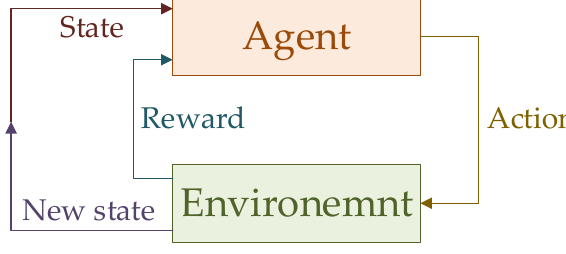
Figure 2. Block diagram of reinforcement learning (RL)